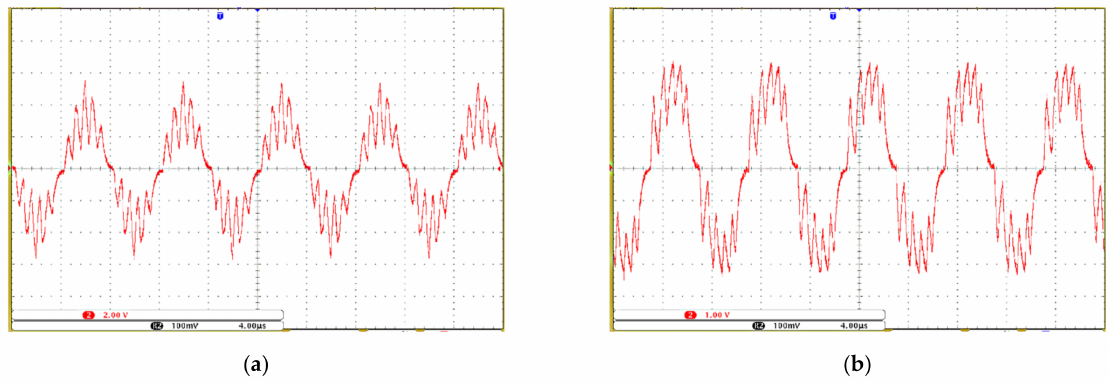
Figure 13. Comparison waveforms of current by regulating voltage: ( a ) before regulating, ( b ) af- ter